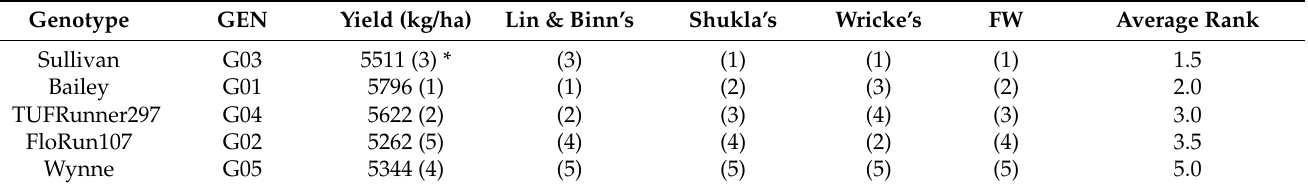
Table 5. Mean yield and average stability ranking of 5 Virginia- and runner-peanut cultivars tested across 13